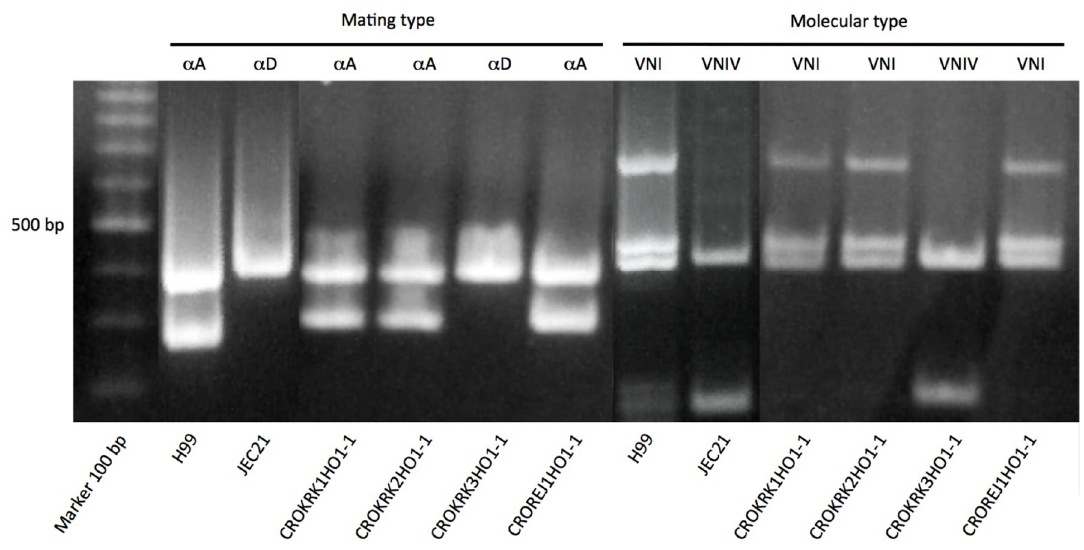
Figure 2. Multiplex PCR results showing mating type and molecular type identification of the four Croatian Cryptococcus neoformans species complex isolates. H99 and JEC21 represents the reference strains, VNI-αA and VNIV-αD, respectively. The 100 bp DNA ladder (Promega, Madison, WI, USA) was used as molecular DNA ladder. CROKRK = isolates from Krk Island; CROREJ = isolate from Rijeka.